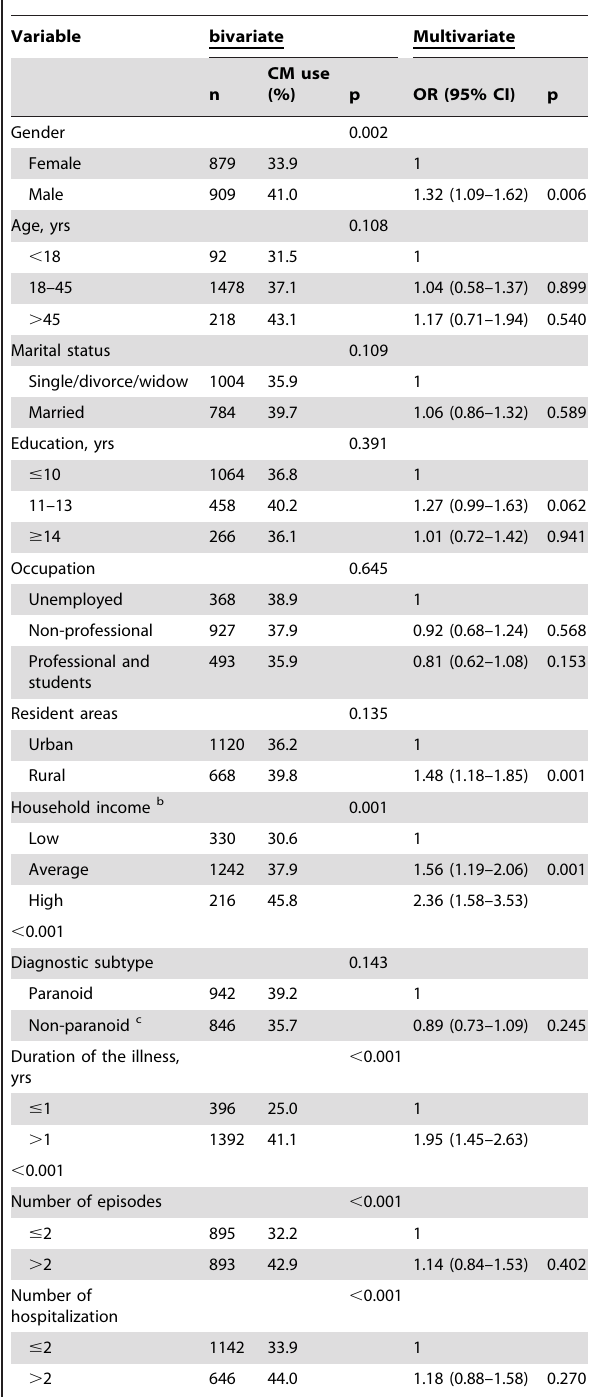
Table 1. Bivariate and multivariate associations of CM use with demographic and clinical variables in patients with schizophrenia under antipsychotic medication. a